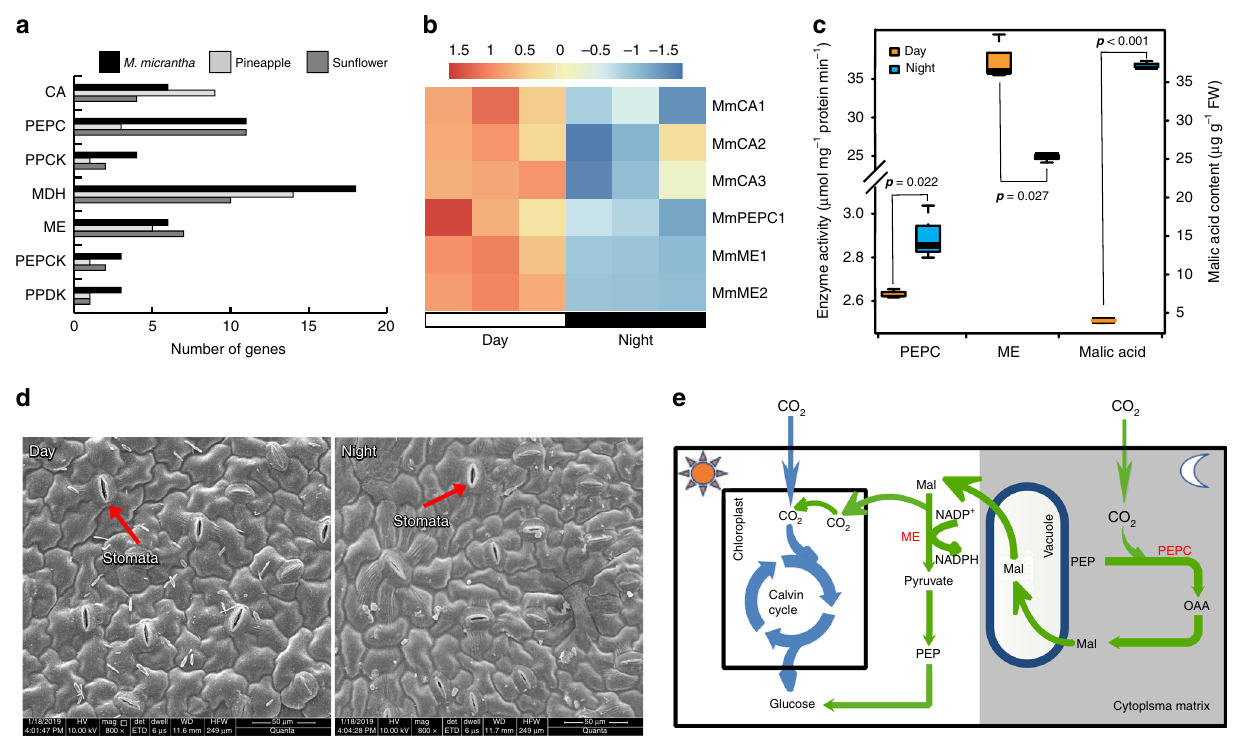
Fig. 3 The special photosynthetic system in Mikania micrantha. a The number of putative carbon fi xation genes in M. micrantha , pineapple and sun fl ower. The gene number of pineapple was obtained from the literature 28 ; carbonic anhydrase (CA), phosphoenolpyruvate carboxylase (PEPC), phosphoenolpyruvate carboxykinase (PEPCK), malic enzyme (ME), malate dehydrogenase (MDH), and pyruvate orthophosphate dikinase (PPDK). b Expression pattern of CAM pathway key genes in M. micrantha across the diurnal expression data. The R-package (pheatmap)-transformed transcripts per kilobase million (TMP) expression pro fi les are shown. The gene names of M. micrantha are shown on the right. The gene expression of each replicate sample in two time points (9 A.M. and 9 P.M.) presented in the heatmap. c The diurnal variation pattern of key enzyme activities and malic acid content in M. micrantha leaves at 9:00 A.M. (day) and 9:00 P.M. (night). The y -axis on the left shows the activity of PEPC and NADP-linked ME. Statistical signi fi cance ( n = 3) determined using the two-sided Student ’ s t test. On each box plot, the central mark indicates the median, the bottom and top edges of the box indicate the interquartile range (IQR) and the whiskers represent the maximum and minimum data points. d Scanning electron microscopy (SEM) of stomata in M. micrantha leaves during the day and at night. SEM images of the samples were taken using a scanning electron microscope (Q25, FEI, USA). e Schematic of the CAM and C 3 photosynthesis proposed pathways of M. micrantha . The enzymes in the CAM pathway of M. micrantha are shown